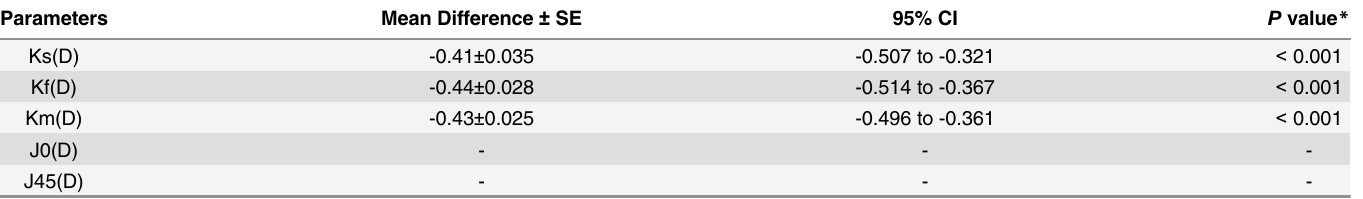
Table 9. Comparison of Ks, Kf and Km obtained by iTrace and IOLMaster. (Note: Ks: steep keratometry, Kf: flat keratometry, Km: mean keratometry, D: diopter, SD: standard Error, 95% CI: 95% consistent interval, * Bonferroni corrected.) Parameters